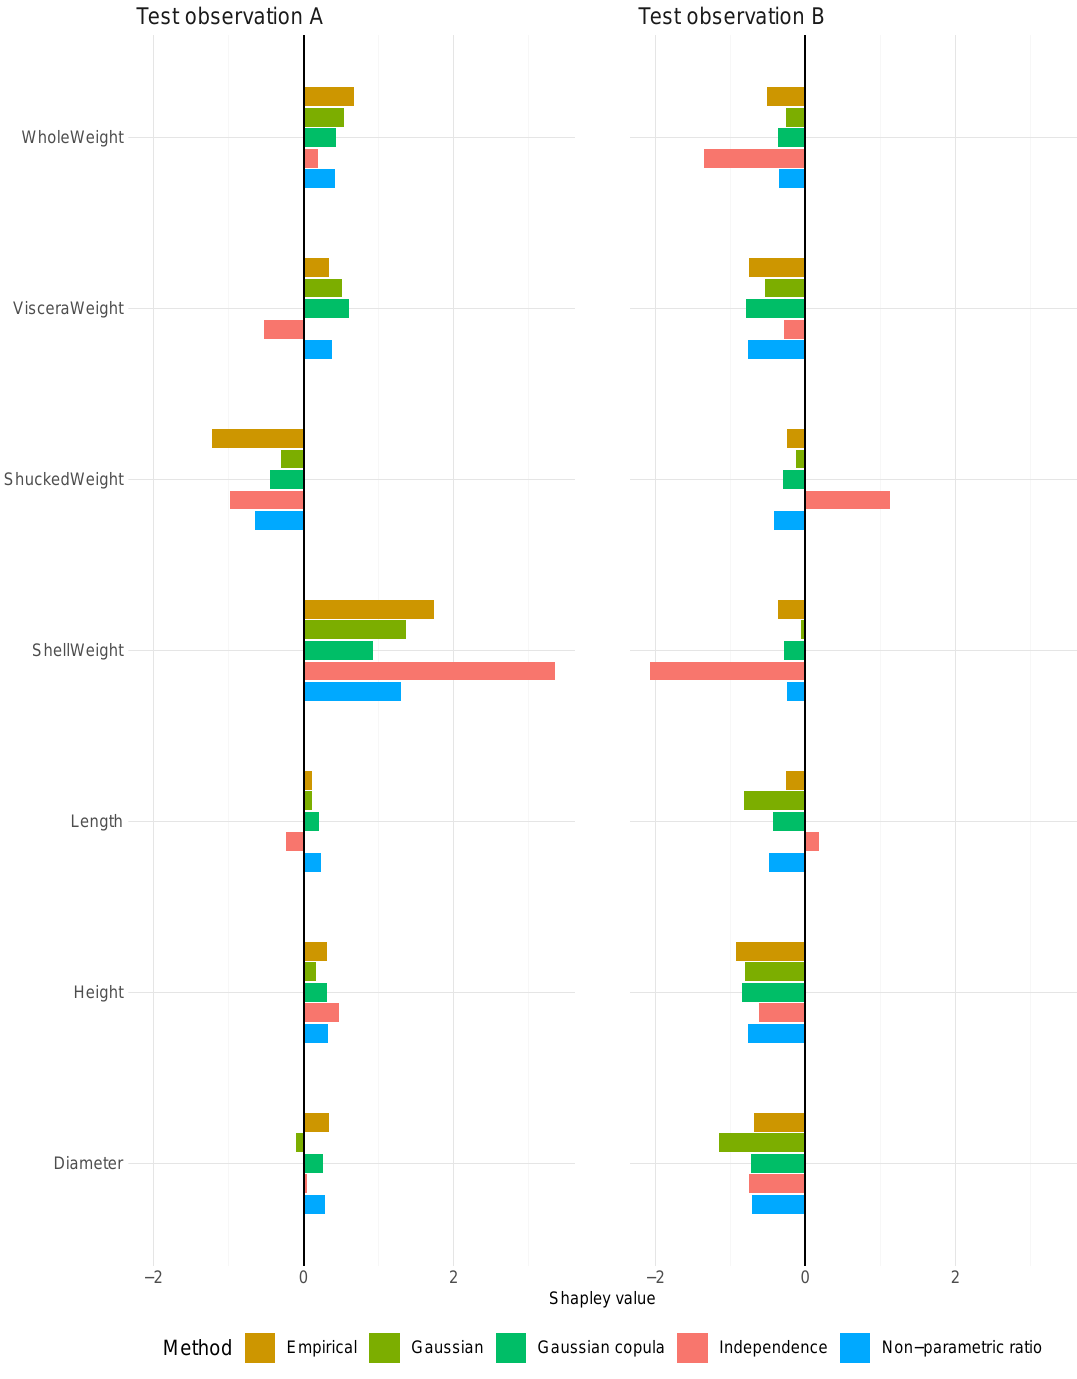
ated by the Gaussian copula and non-parametric ratio approaches are more realistic than those generated by the independence approach. Further, for the majority of the test observations/conditional distributions, the Mahalanobis distances corresponding to the non-parametric ratio approach are smaller than those cor- responding to the independence and Gaussian copula